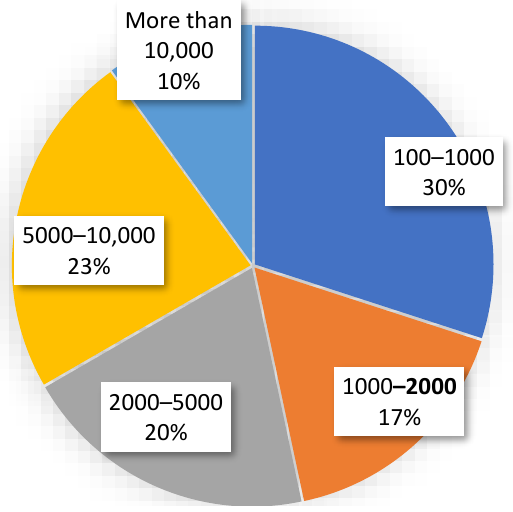
Figure 3. Type of projects handled by the respondents.